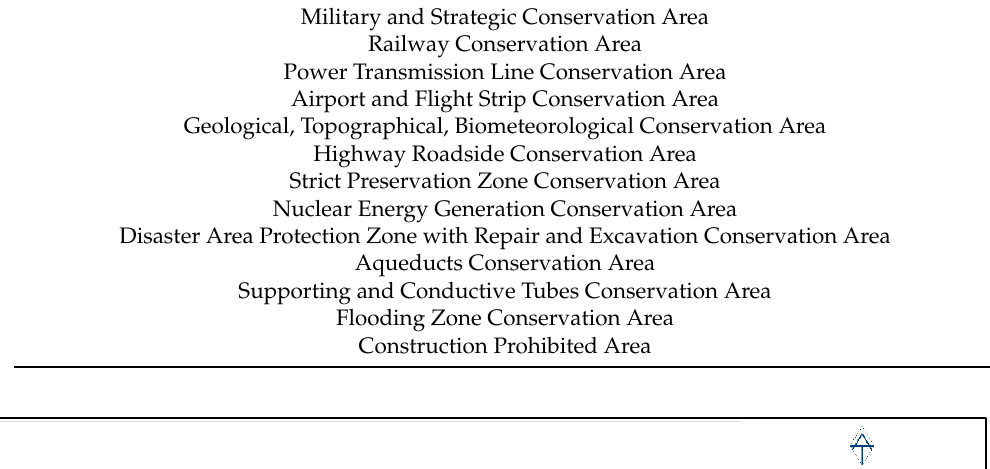
Table 2. Construction Prohibited Area Subclasses.